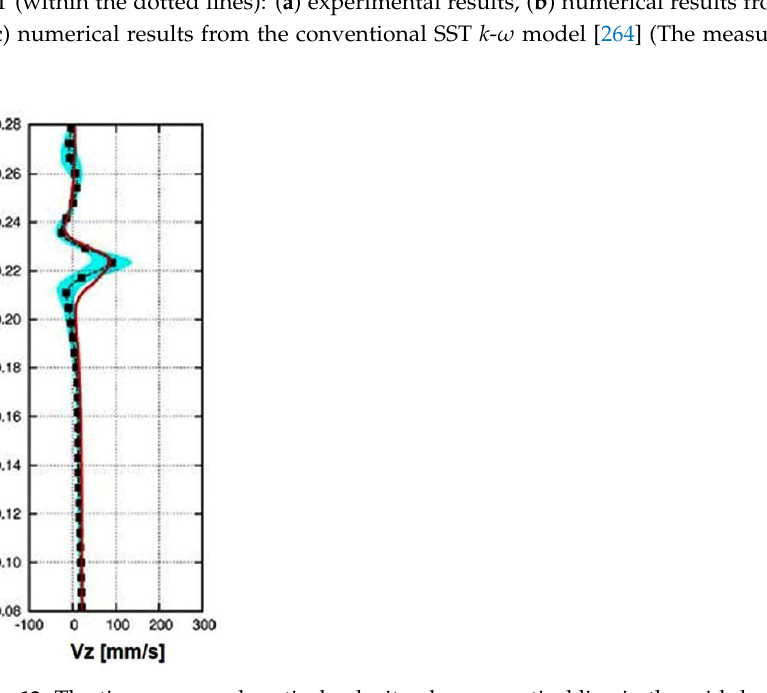
Figure 12. The time-averaged vertical velocity along a vertical line in the midplane at x = 0.045 m (B0 = 310 mT with electrically conducting mold) [264] (The data extraction line in Figure 10).